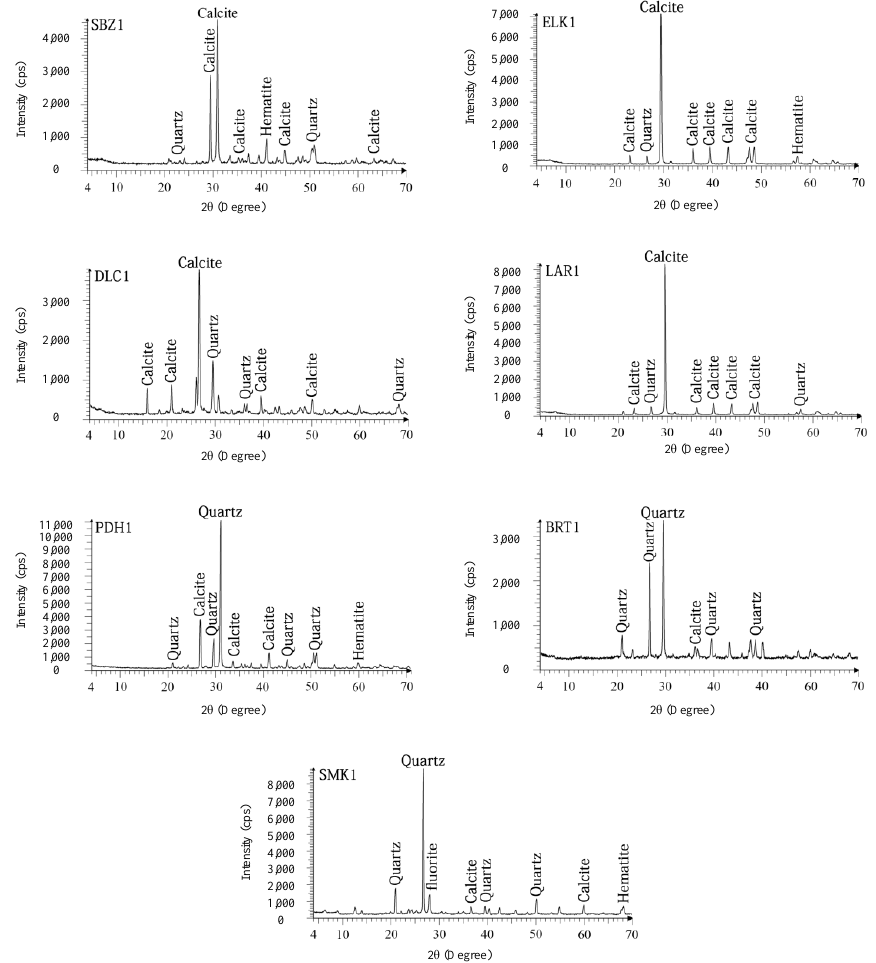
Figure 6. XRD graphs of the studied rock samples.